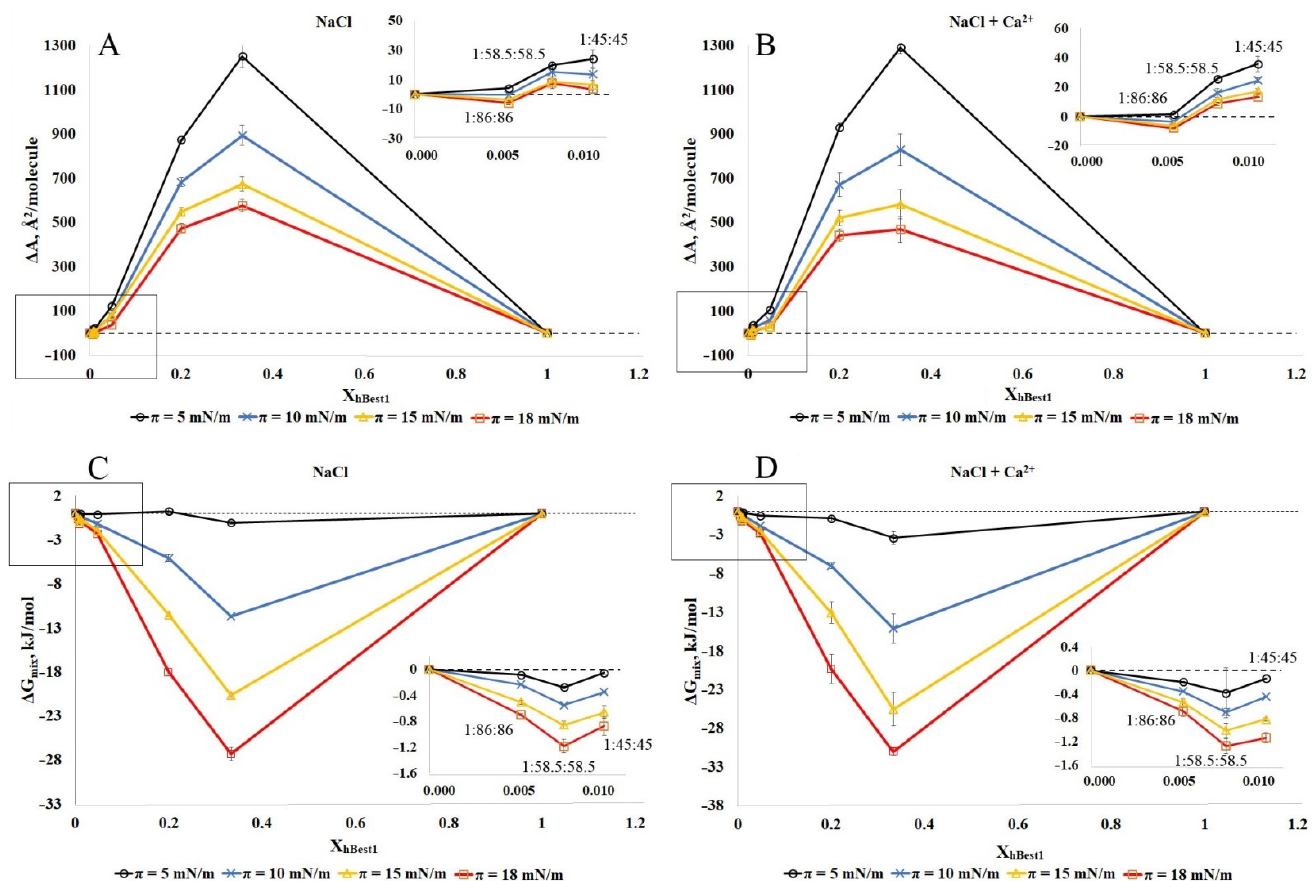
Figure 7. Plots of the deviation of the area from the additivity ( Δ A) ( A , B ) and the total free energy of mixing ( ∆ G π ) ( C , D ) versus film composition (X hBest1 ) at different surface pressures of mix hBest1/SM/Chol monolayer in a subphase of 150 mM NaCl ( A , C ) and in 150 mM NaCl supple- mented with 0.5 µM CaCl 2 ( B , D ) at 35 ± 2 °C (inset: enlargement of the framed area).